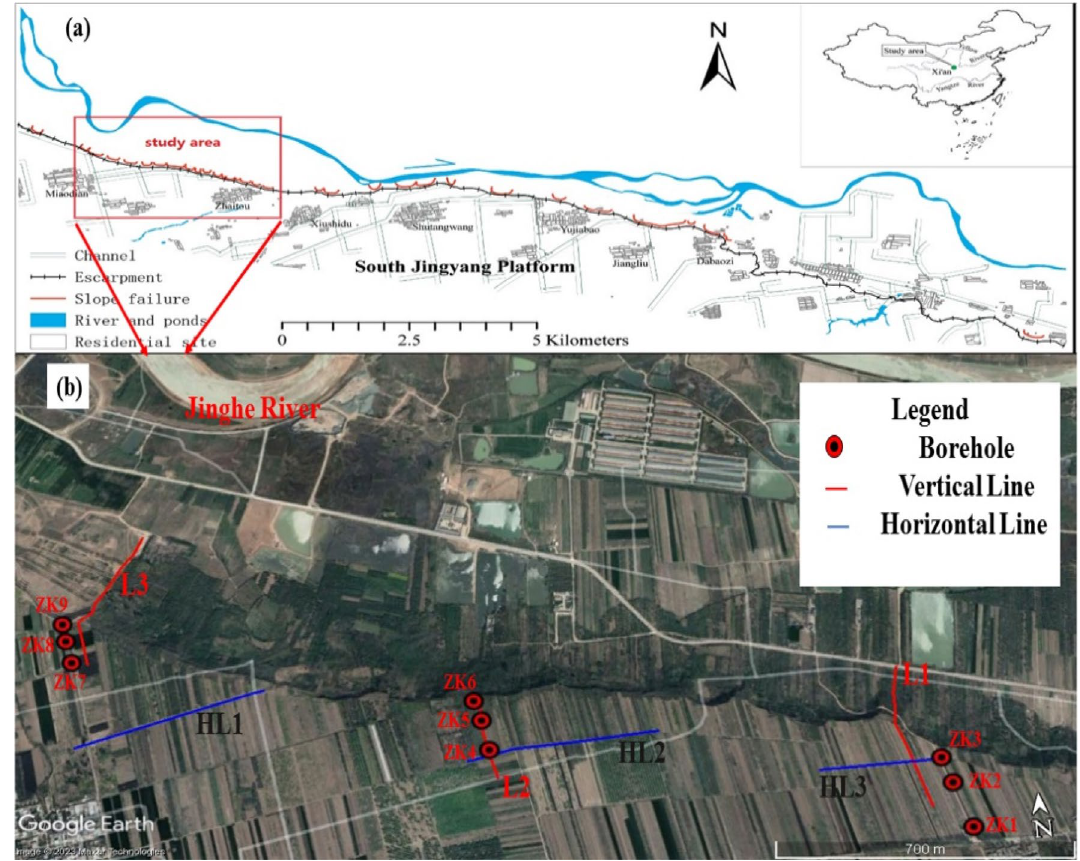
Figure 1. ( a ) Location map of the study area 13 ( b ) location map of high-density survey lines and boreholes.